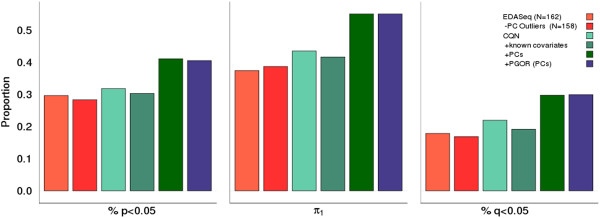
eQTL replication in blood data. Colors correspond to the comparable analyses carried out in the brain data (Figure 2). Again, these data show that CQN (green bars) slightly improves eQTL detection over EDASeq (red bars) and that a considerable increase in eQTL detection is seen when unknown covariates are considered in the analysis.